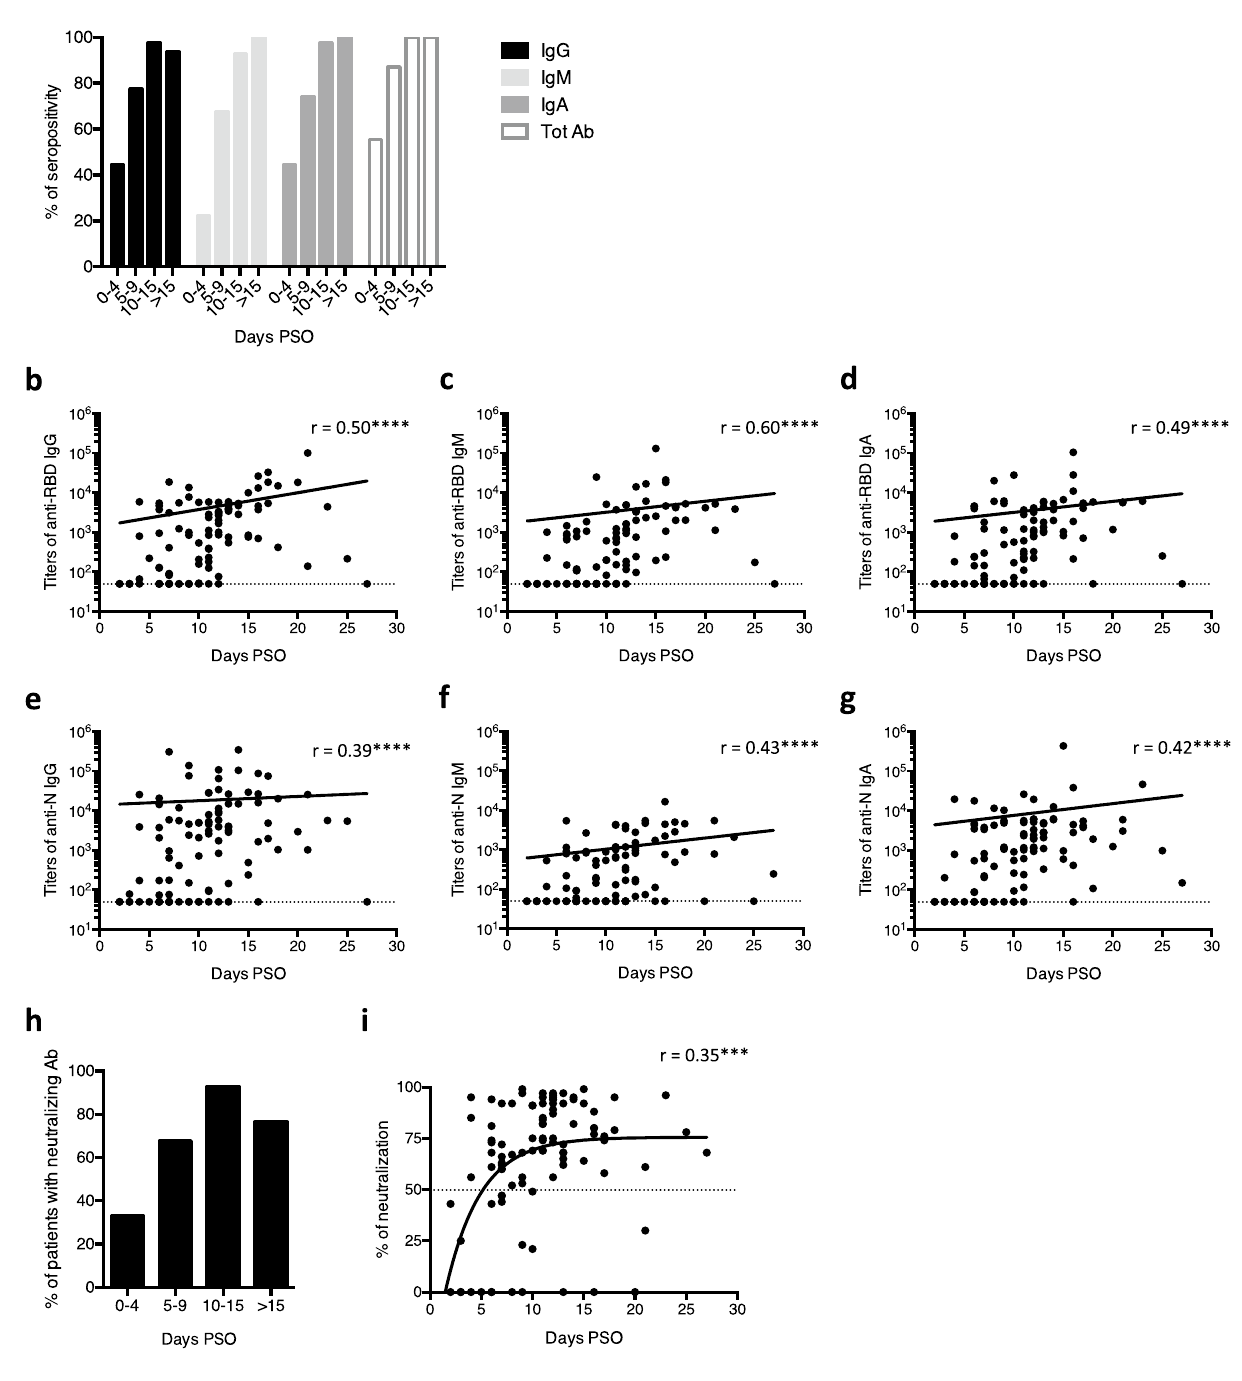
Figure 3. Kinetics of antibody responses against SARS-CoV-2 in hospitalized COVID-19 patients. Hospitalized COVID-19 patients include non-ICU, ICU and deceased COVID-19 patients. ( a , h ) Percentage of seropositivity ( a ) and percentage of patients with neutralizing antibodies ( h ) in hospitalized COVID-19 patients, according to time between symptom onset and sample collection. Seropositivity corresponds to the presence of anti-RBD and/or anti-N antibodies in serum/plasma. Serum/plasma collection was performed 0–4 days post-symptoms onset (PSO) in 9 patients, 5–9 days PSO in 31 patients, 10–15 days PSO in 42 patients and more than 15 days PSO in 16 patients. ( b – g , i ) Titers of anti-RBD IgG ( b ), IgM ( c ) and IgA ( d ), titers of anti-N IgG ( e ), IgM ( f ) and IgA ( g ) and spike-pseudotyped lentiviral neutralization ( i ) in hospitalized COVID-19 patients according to the time between symptom onset and sample collection. Each dot represents one sample. Dashed line represents the positivity threshold. The preferred model for best fit curve (solid line) was assessed by an extra sum-of-squares F test and is a semi-log line ( b – g ) or a one-phase association ( i ). The Spearman’s correlation coefficient (r) is shown. *** p < 0.001, **** p < 0.0001 (Spearman